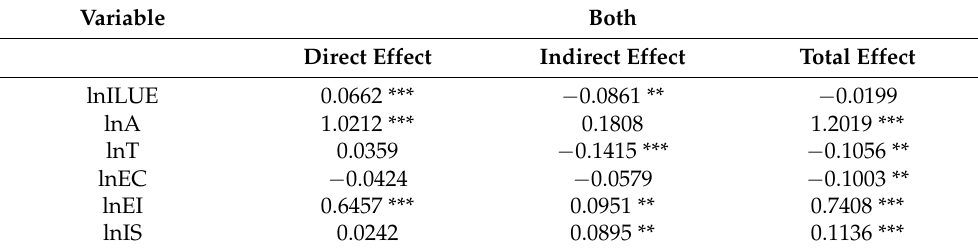
Table 7. Spatial Durbin indirect effect and direct